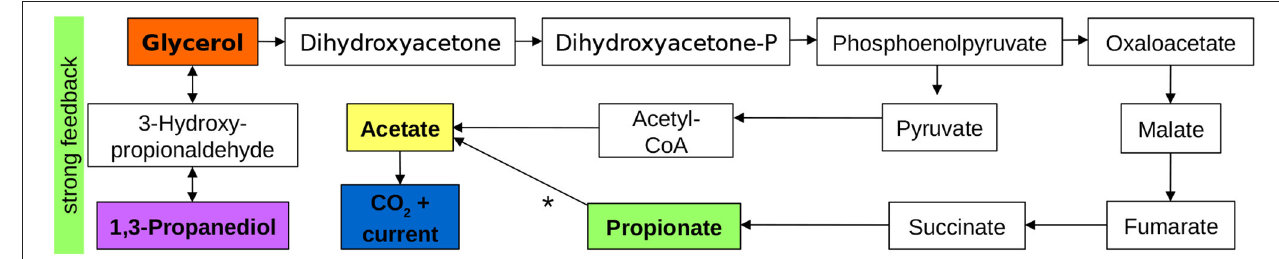
FIGURE 4 | Main active pathways and interactions during glycerol electro-oxidation in an MFC. Substances in colored boxes were measured directly, intermediates are based on da Silva et al. (2009). The pathway from propionate to acetate, denoted by a * is unclear.